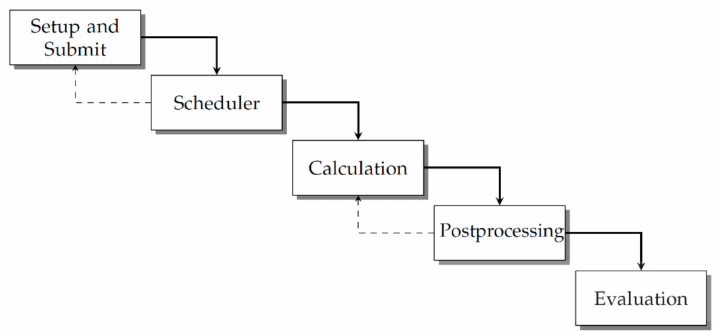
Figure 3. Our implementation of an automated CFD workflow with two optional loops for parameter